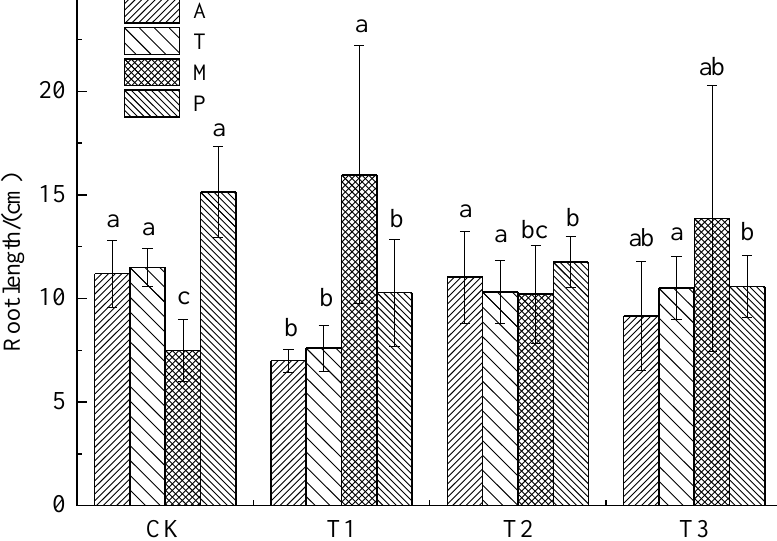
Figure 2. Root lengths of native plants species under different treatments in Pb-polluted soil. Data shown were means ± standard error ( n = 5), and different letters (a, b, c) represent significant differences at p < 0.05.